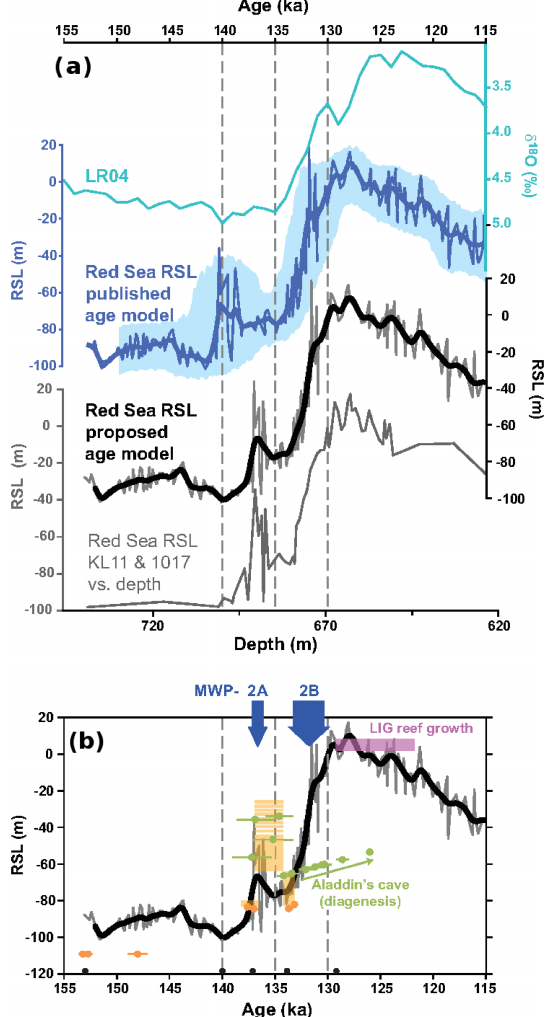
Figure 7. Sea-level changes across the PDG: (a) stacked LR04 ben- thic δ 18 O curve (turquoise) (Lisiecki and Raymo, 2005) and Red Sea relative sea-level (RSL) data (1kyr moving Gaussian filter in dark blue line and 95% probability interval in light blue) in the age model from Grant et al. (2012) and in the new age model (this study, data in grey, 1kyr moving Gaussian filter in black); RSL curve inferred from Red Sea Geo-KL11 and MD92-1017 cores on a depth scale (dark grey) (Grant et al., 2012). (b) Tahiti (orange dots) (Thomas et al., 2009) and Huon Peninsula (green dots) (Esat et al., 1999) corals superimposed onto the Red Sea RSL curve dis- played in the new age model (black). Orange bars indicate the range of the paleo-water depth estimates from Tahiti corals. Coral data have been updated to new decay constants (Cheng et al., 2013) (Tables S3, S4). Black dots indicate the tie points defined so that the timing of MWP-2A in the Red Sea RSL is consistent with the absolutely dated Tahiti and Huon Peninsula coral data (Table S5). The pink box represents the timing and range of RSL during the main phase of LIG reef growth (129–122ka) (Dutton and Lambeck, 2012). Vertical dashed grey lines indicated the 140, 135 and 130kyr time intervals in both